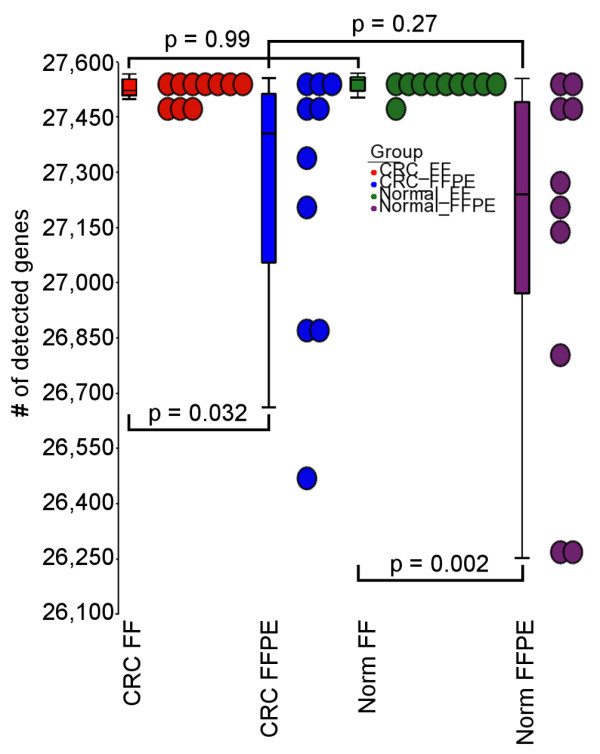
Number of loci detected in each sample group. The sample groups shown are: tumor FF tissue (red, average detected loci = 27530.6 ± 27.4); tumor FFPE tissue (blue, 27,239.0 ± 375.4), normal FF tissue (green, 27,541.1 ± 26.7), and normal FF tissue (violet, 27,102.5 ± 502.0). There was significant difference between average detected loci in normal FF vs. normal FFPE (p = 0.002) and between tumor FF vs. tumor FFPE (p = 0.032).